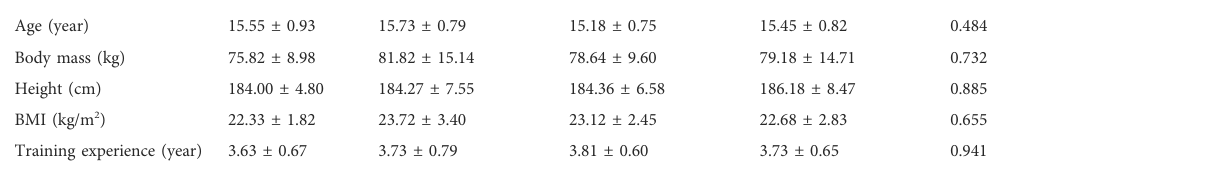
TABLE 1 Participants characteristics (mean ±